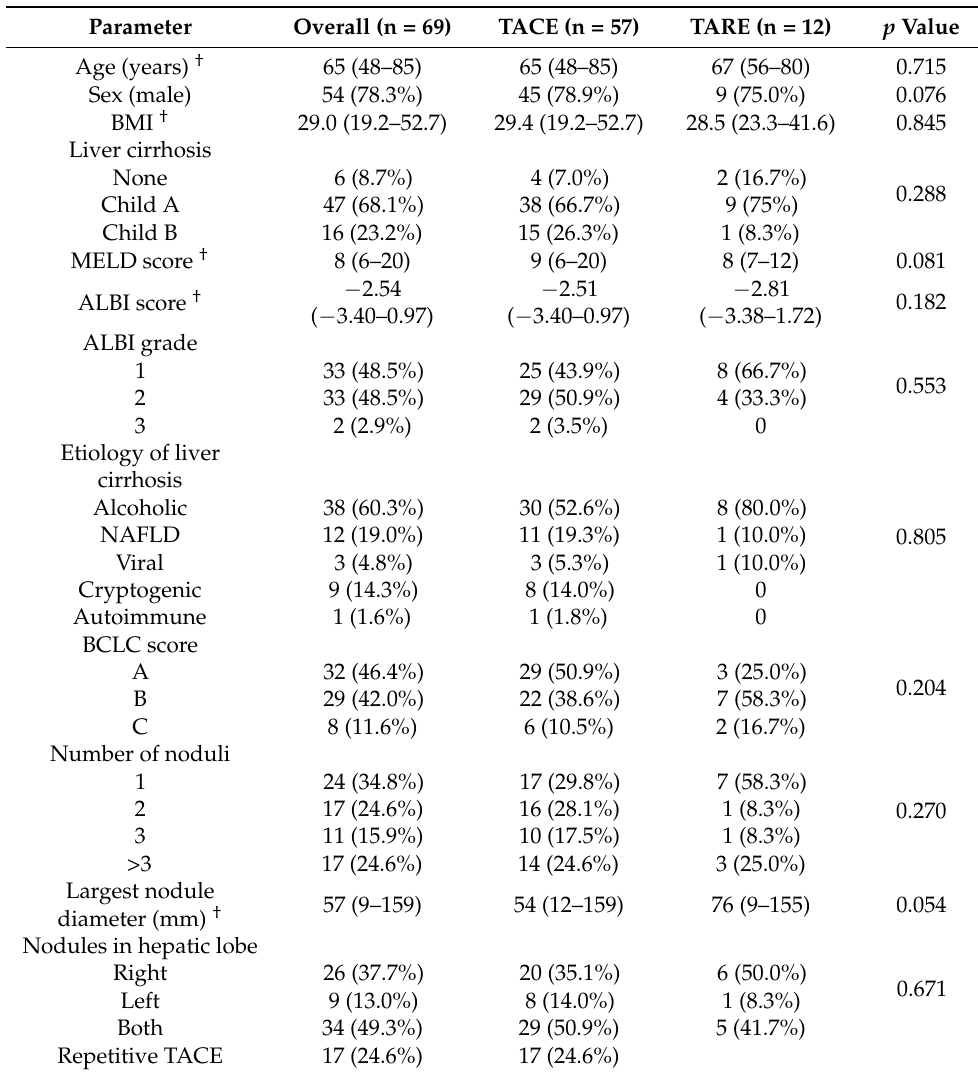
Table 1. Baseline patients’